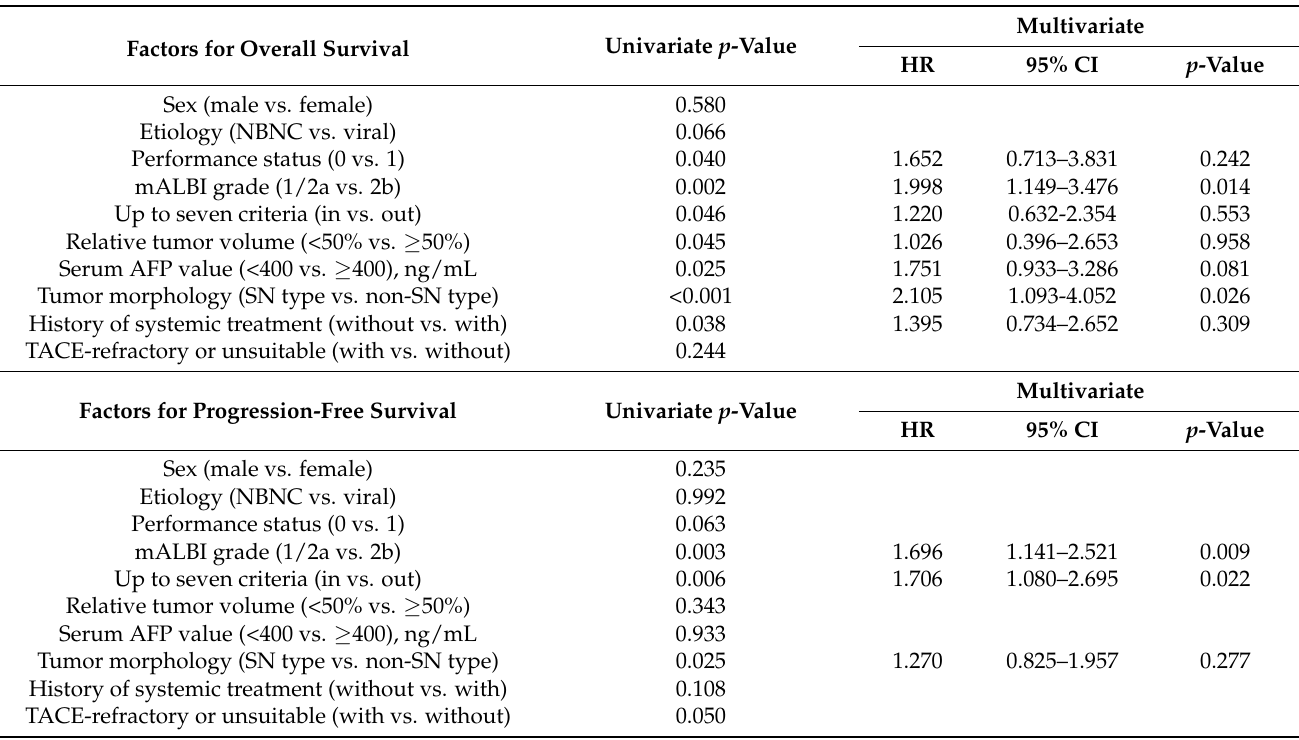
Table 3. Univariate and multivariate analyses of prognostic factors for overall and progression-free